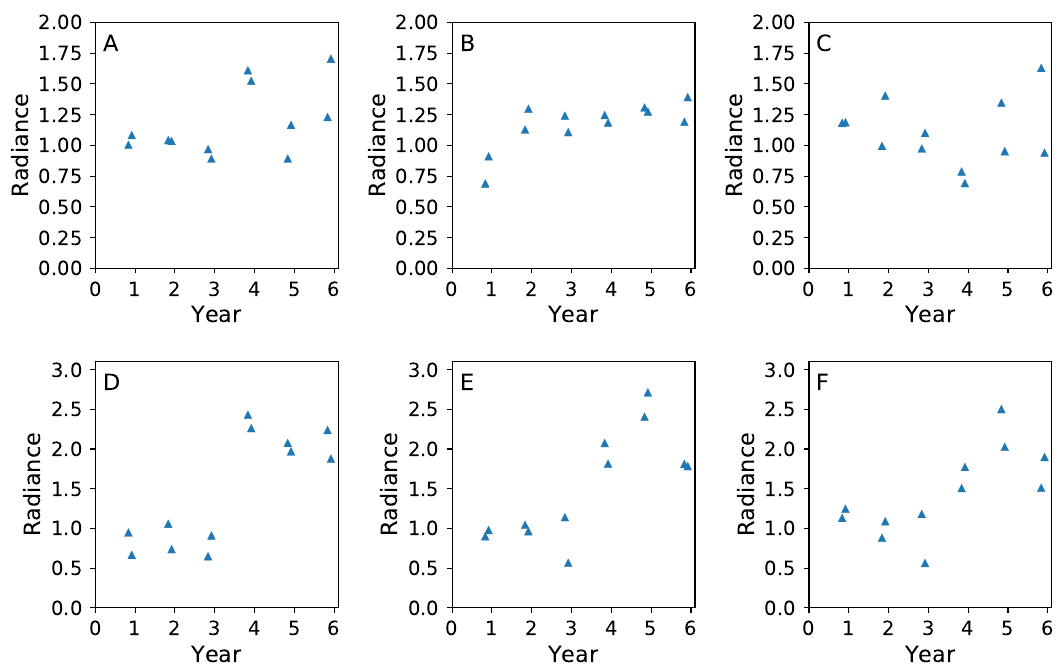
Figure 10. Simulated six-year DNB time series showing only data for October and November. The points shown are drawn directly from the simulated dataset shown in Figure